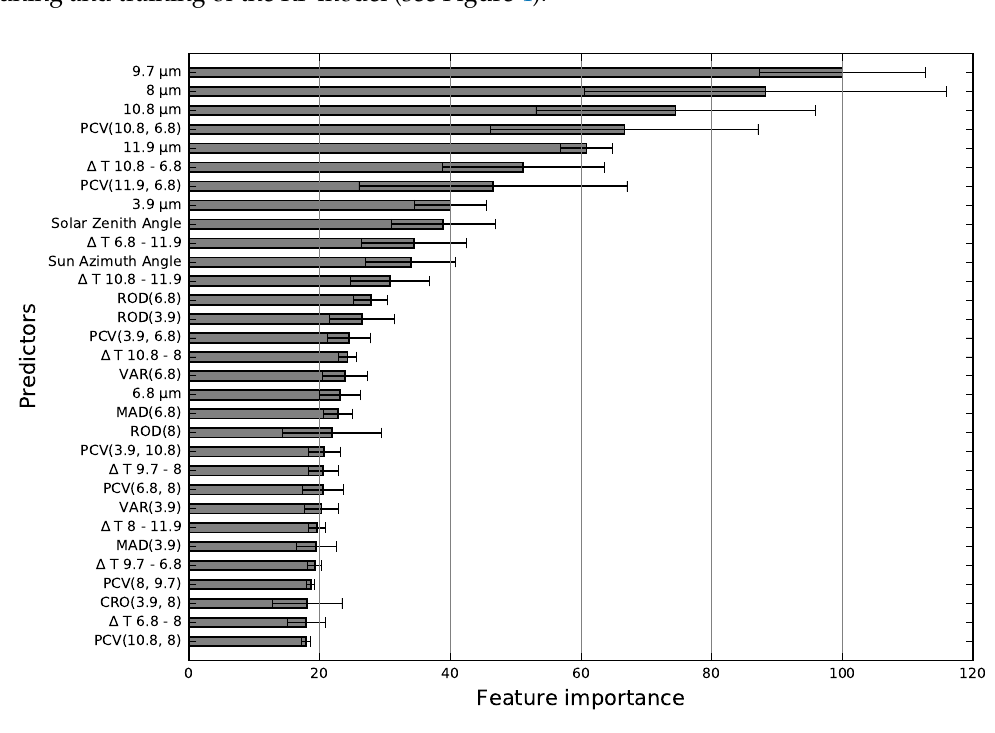
Figure 4. Average feature importance and standard deviations relative to the most important feature of the feature space. Feature importance was calculated for a subset of all available scenes from the training data set using all non-static predictors. The error bars were calculated based on one standard deviation of each